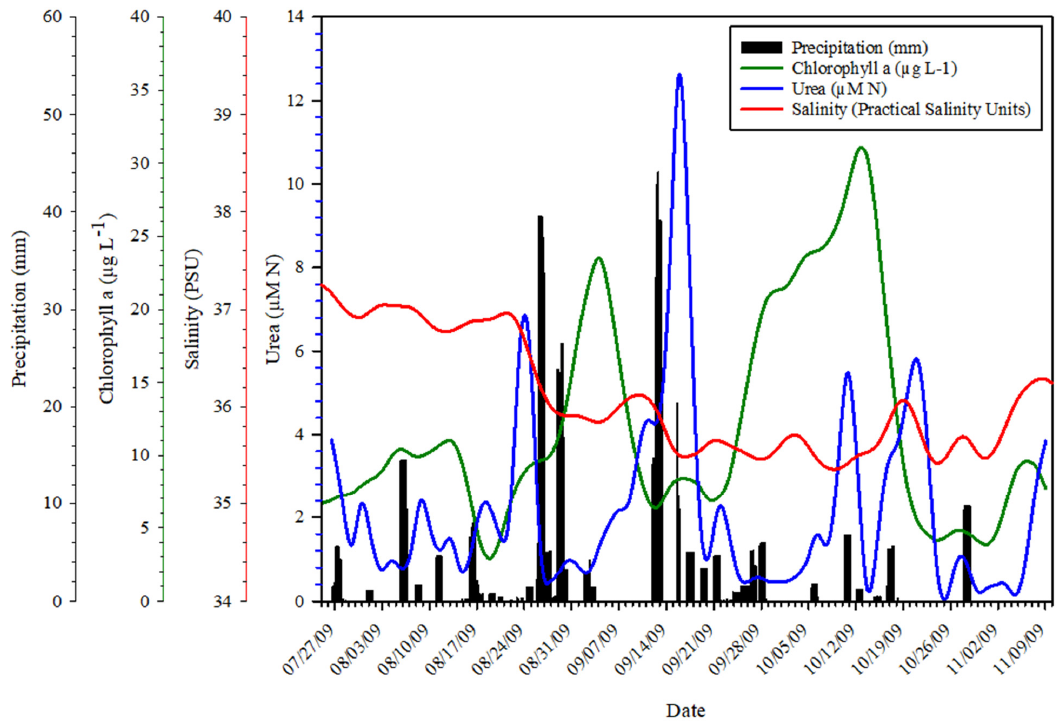
Figure 3. MARVIN deployment data from 29 July to 9 November 2009. Phytoplankton blooms are represented by chlorophyll- a values. Associated precipitation, urea and salinity data recorded by MARVIN sensors are also plotted. The time series data collected at Station 3, where the MARVIN platform was deployed in Sarasota Bay, indicate that several blooms occurred following rain events which altered ambient urea and salinity concentrations.